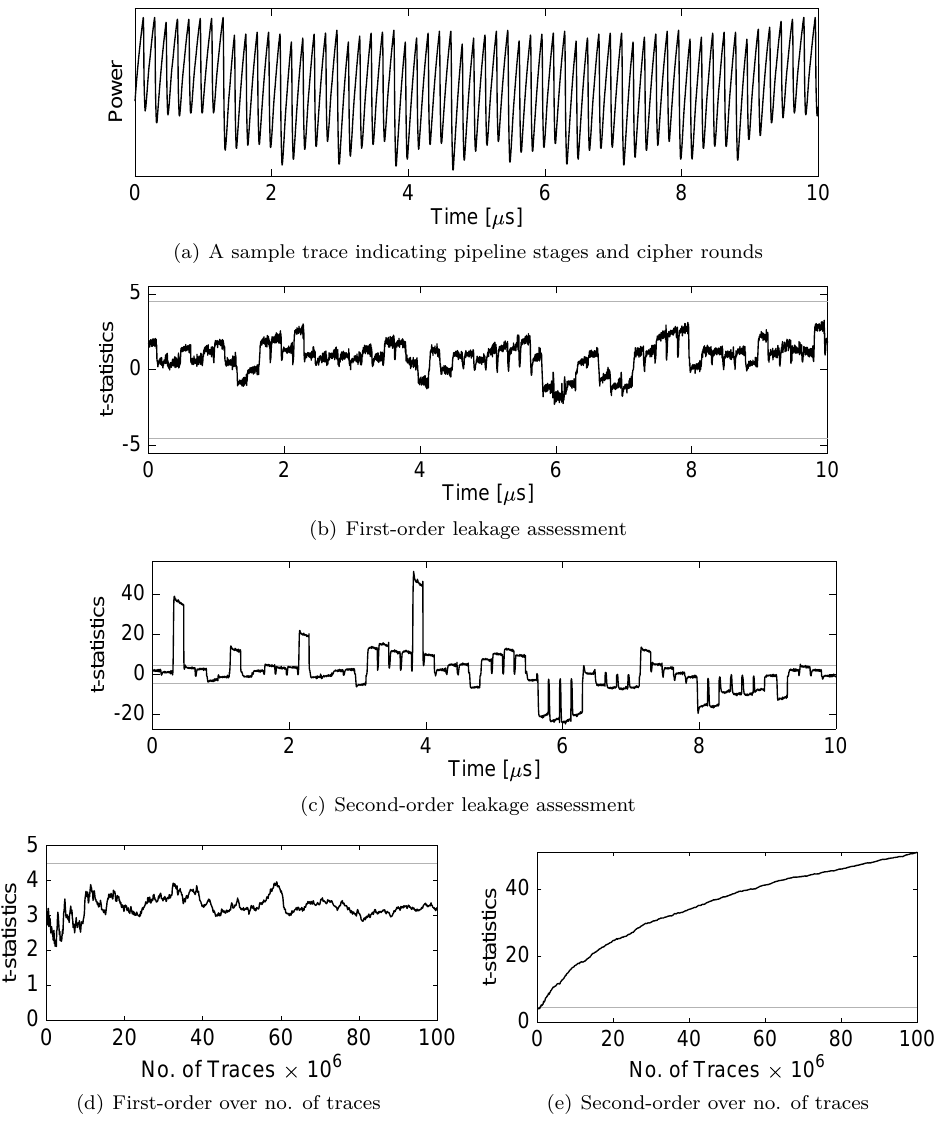
Figure 4: First- and second-order leakage assessment results of our fully-pipeline AES encryption module, using 100 million power